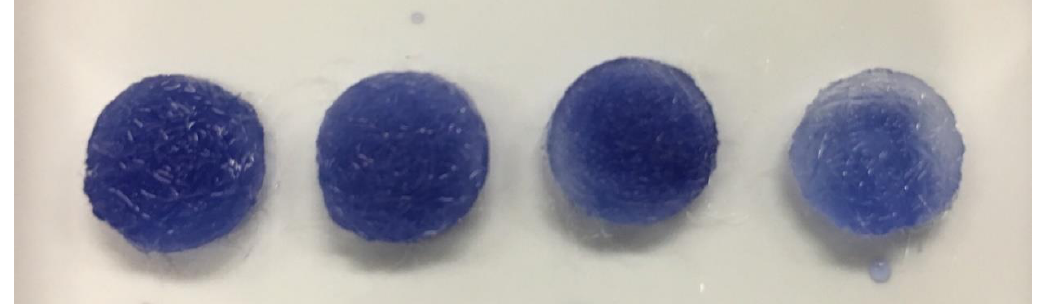
Figure 6. Flow velocity profile.